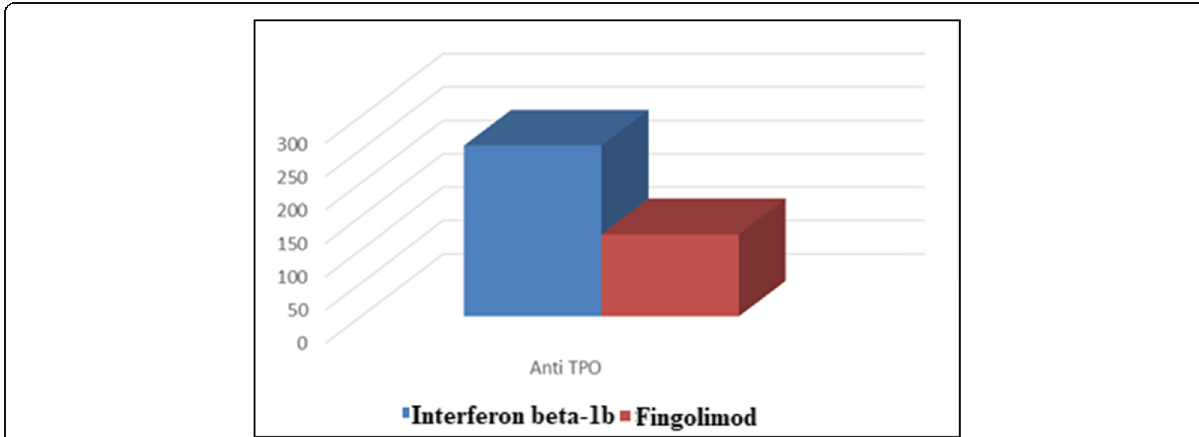
Fig. 3 The association between DMDs and levels of anti-TPO